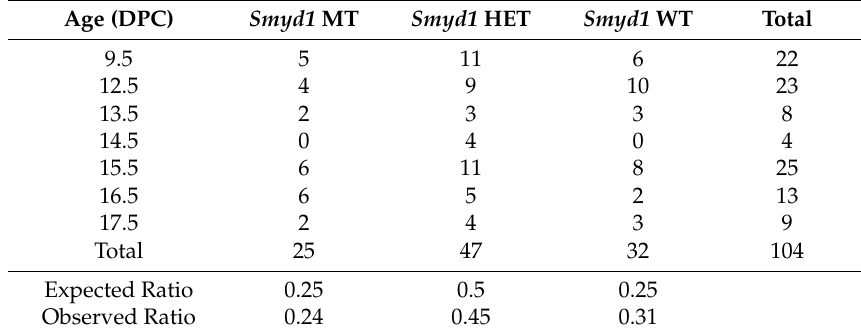
Table 1. Skeletal muscle-specific SMYD1 CKO does not alter Mendelian ratios prior to birth. Age